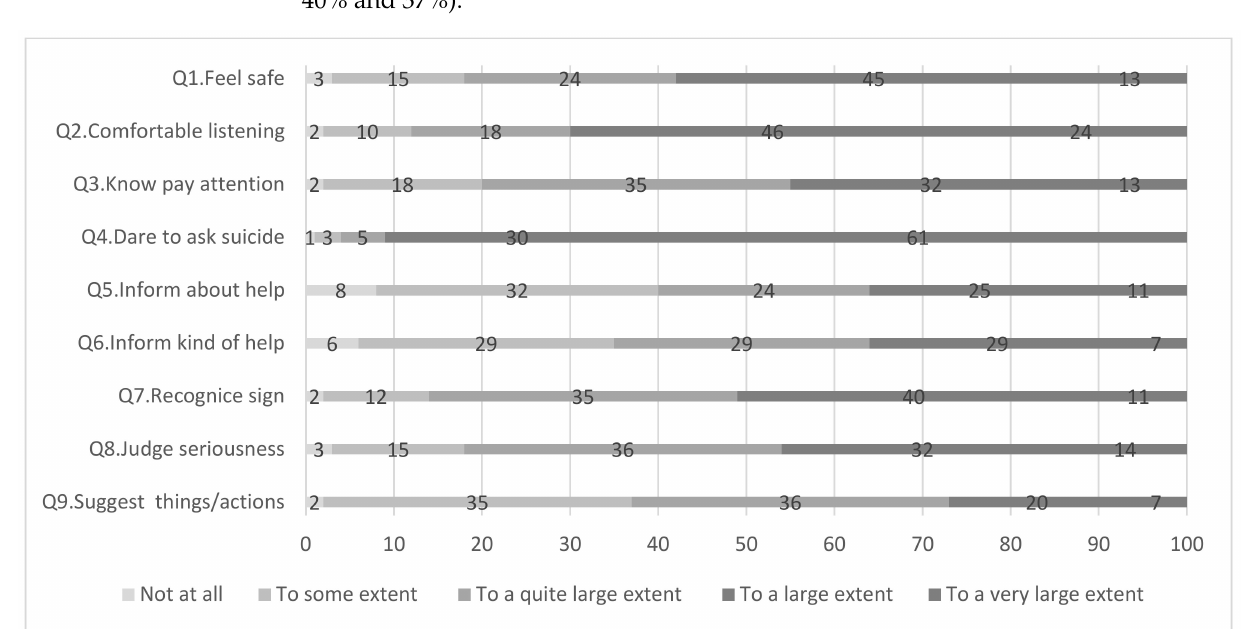
Figure 1. Questions and relative response rates based on a five-point scale, ranging from 1 = ‘not at all’ to 5 = ‘to a very large